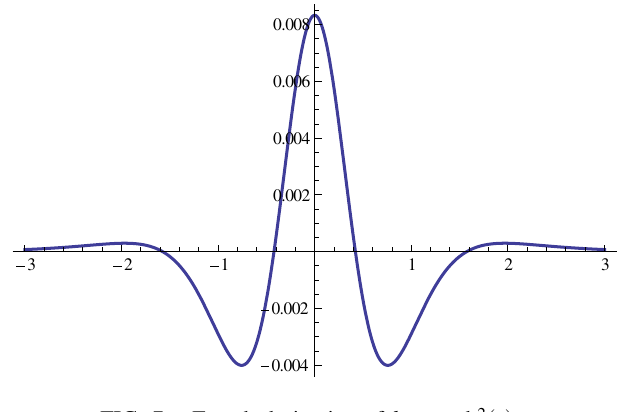
FIG. 7. Fourth derivative of k ¼ sech 2 ð z Þ